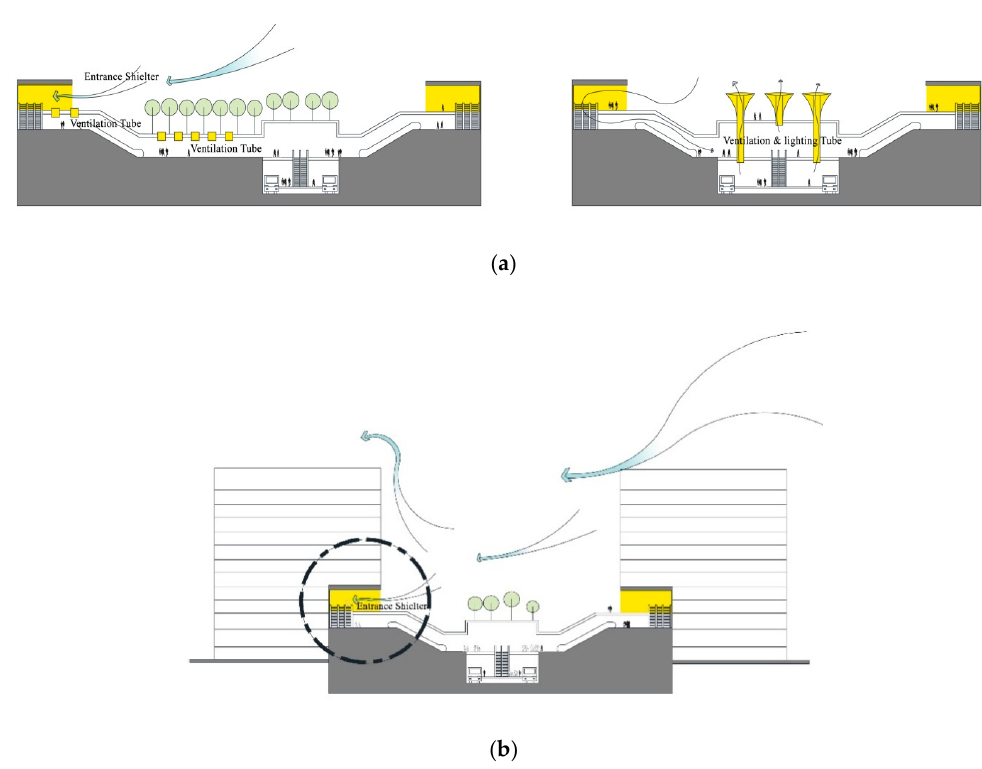
Figure 17. Passive strategy for relieving excessive wind velocity at the tube entrance. ( a ) Setting conversion space in the underground interconnected tubular space; ( b ) Transition buffer space at the tube entrance that combines with the complex building design.